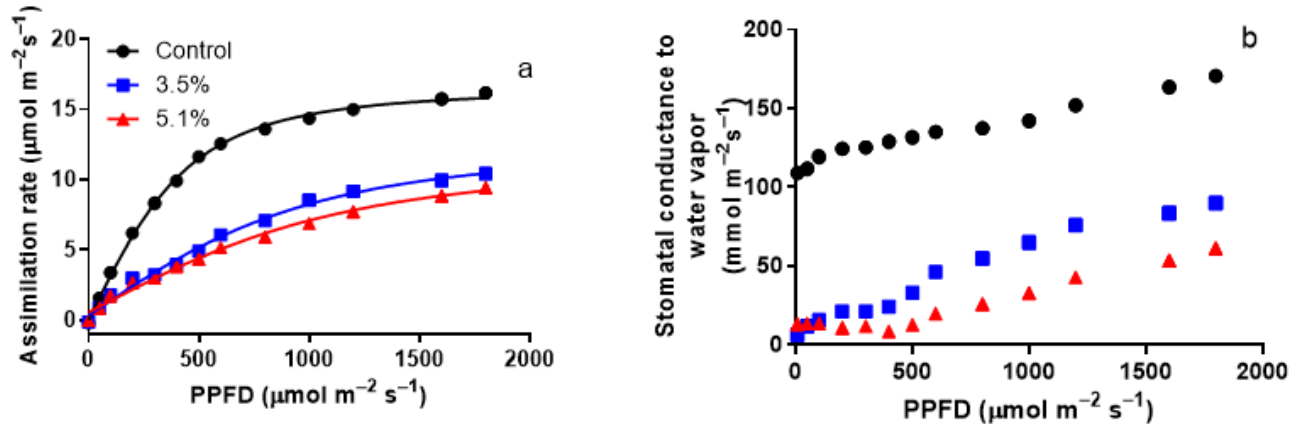
Figure 3. Representative light (photosynthetic photon flux density, PPFD) responses of net CO 2 assimilation rate ( a ) and stomatal conductance to water vapor ( b ) for J. regia control (non-infected) and A. erinea -infected leaves. The inset in ( a ) demonstrates the infection percentages. During the measurements, the environmental conditions other than light were as in Figure 2. The rectangular hyperbola of Smith fitted the light response curve ( a ).